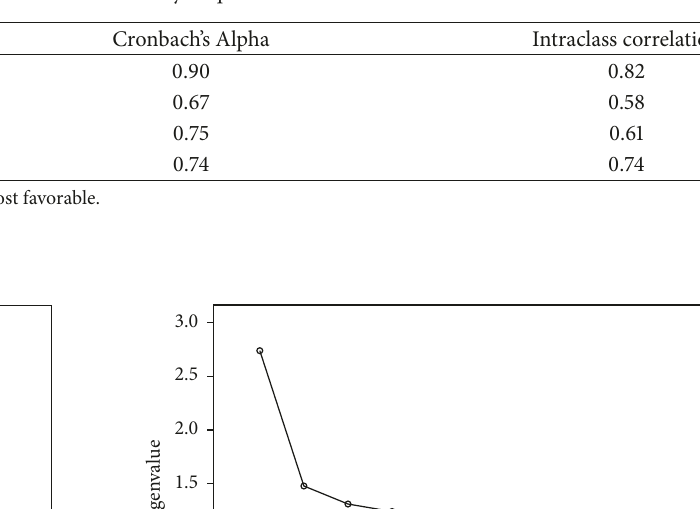
Table 7: Internal consistency and test-retest validity of questionnaire domains indices.